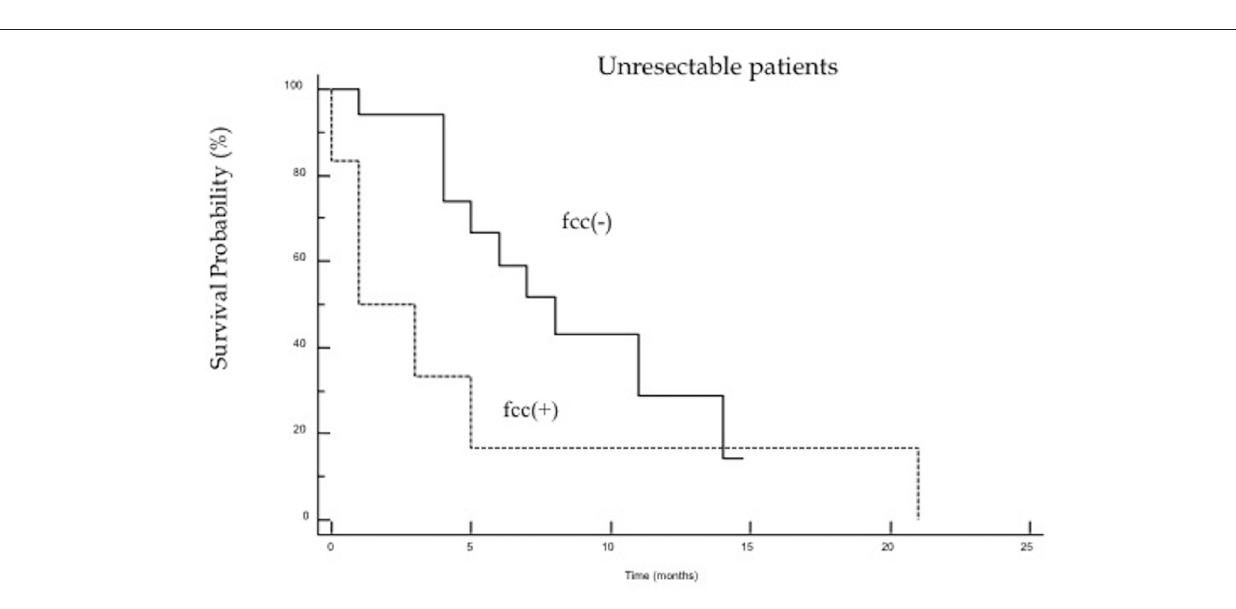
FIGURE 3 | The Kaplan–Meier survival curves for non-resected patients from fcc ( + ) [HR 1.962 (95% CI: 0.617–6.242)] and fcc (–) groups [HR.509 (95% CI: 0.160–1.620), p =